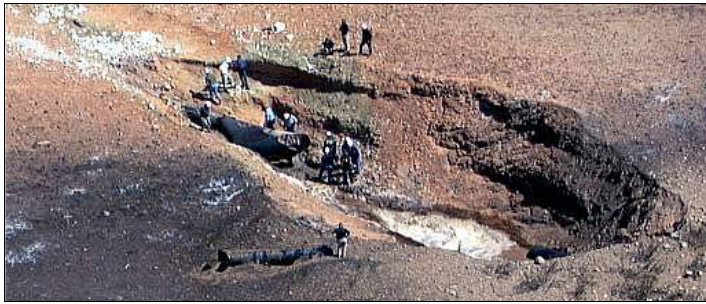
Figure 8 – The crater that was created in the explosion Рис . 8 – Кратер , образованный в результате взрыва Slika 8 – Krater koji je nastao prilikom eksplozije